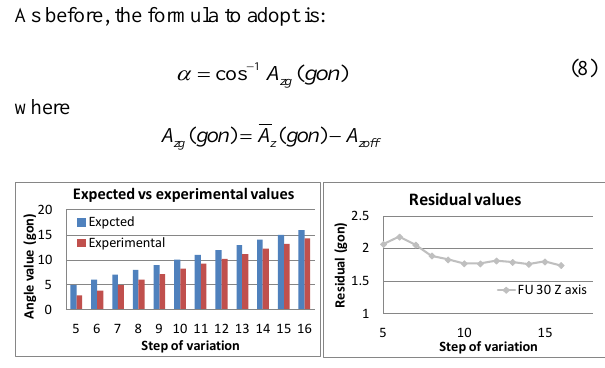
Figure 10. Time history for FU SMAMID n°30 z axis during zenith variation from 300 to 284 gon